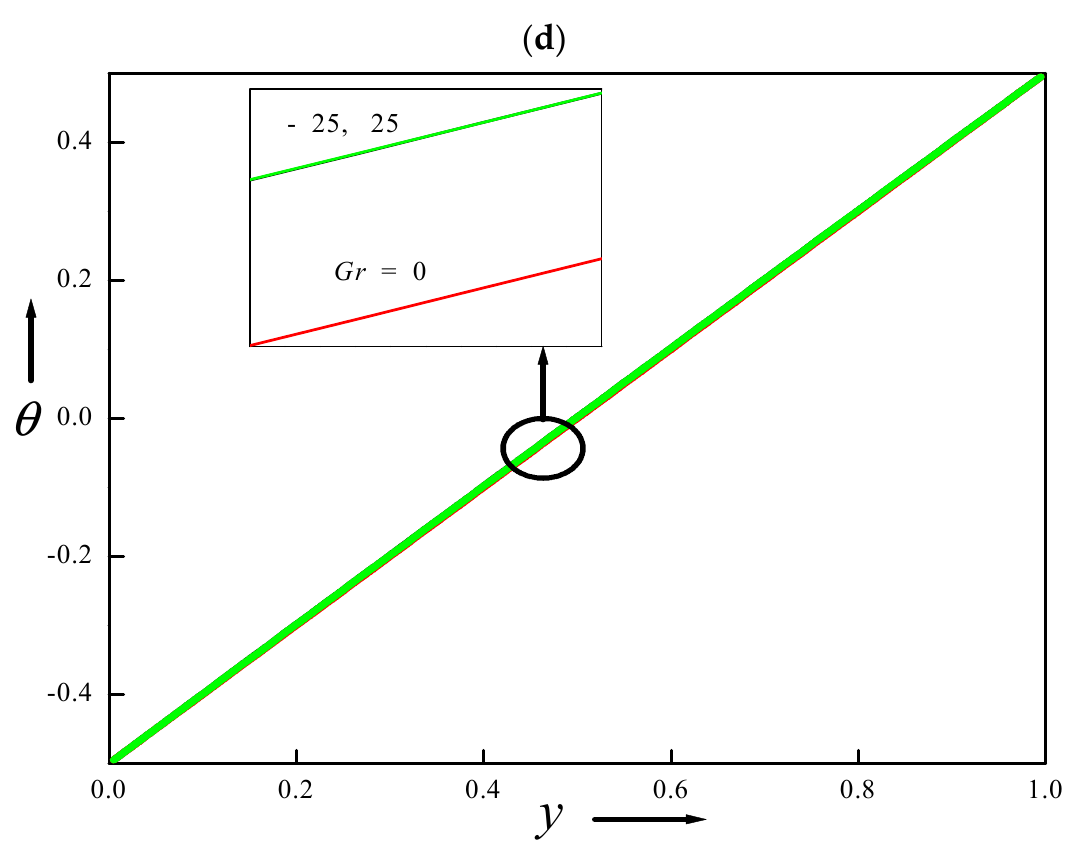
Figure 10. Velocity ( a ) contours, ( b ) profiles; and temperature ( c ) contours ( d ) and profiles for altered Grashof number.